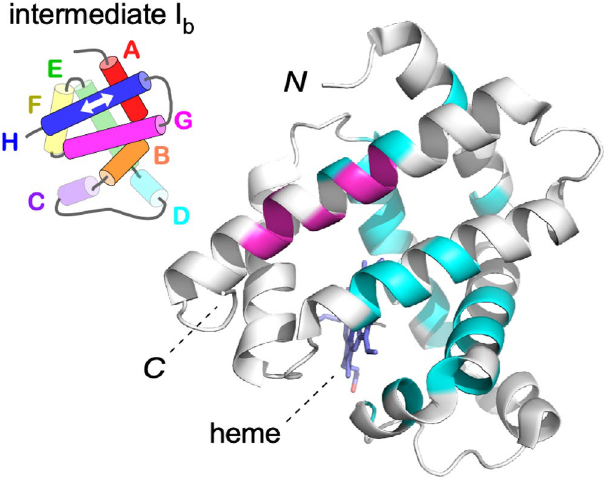
Figure 6. Mapping of the outlier residues in the REFER plot on the N-state structure of myoglobin. The native holo-structure (PDB ID 2JHO) is used as the best alternative to the intermediate structures. The residues on the least-square lines in Fig. 5b are colored cyan and the outlier residues are magenta. The other residues without information are colored white. These unprobed residues include parts of helices A, G, and H due to the full protection of the amide protons, and helix F and the loops due to the lack of local secondary structures in the intermediate states. The inset shows the helical topology of the kinetic intermediate I b . The major portions of helices A, B, G, and H are formed. The half-translucent cylinders represent partially formed helices C, D, and E. The state of helix F is unclear in the folding intermediate states because helix F is not stably packed in the apo state of apomyoglobin. The white arrow indicates the translocation of helix H in the intermediate states, I b